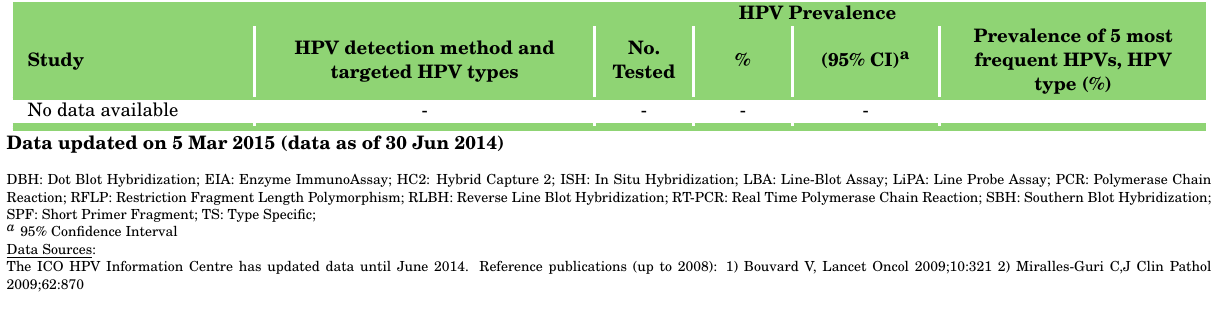
Table 31: Studies on HPV prevalence among penile cancer cases in Peru